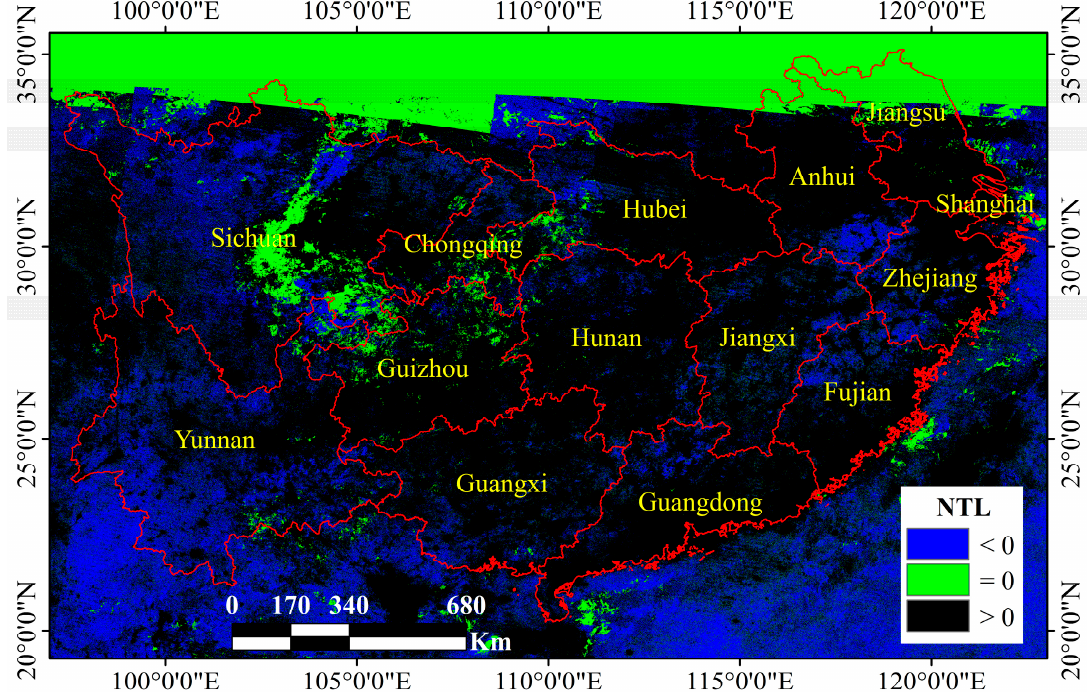
Figure 3. NTL of study area in June 2014. June is the month with minimum spatial coverage of NTL data within a year. The continuous green areas in north part of the image (north area of Jiangsu, Anhui, and Sichuan provinces) are areas with null value.